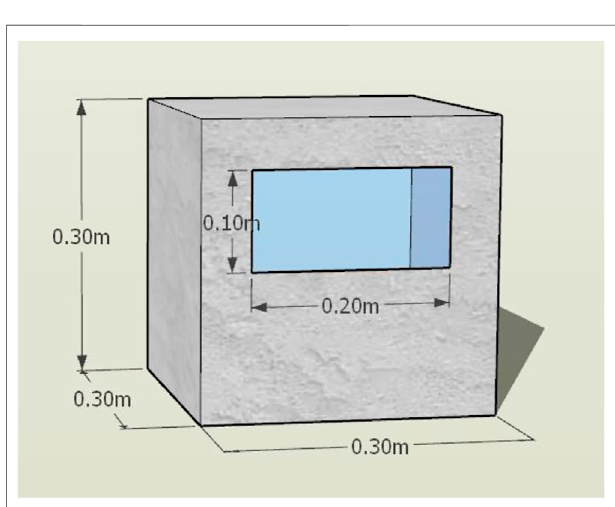
FIGURE 9 | The structure of the simulated building